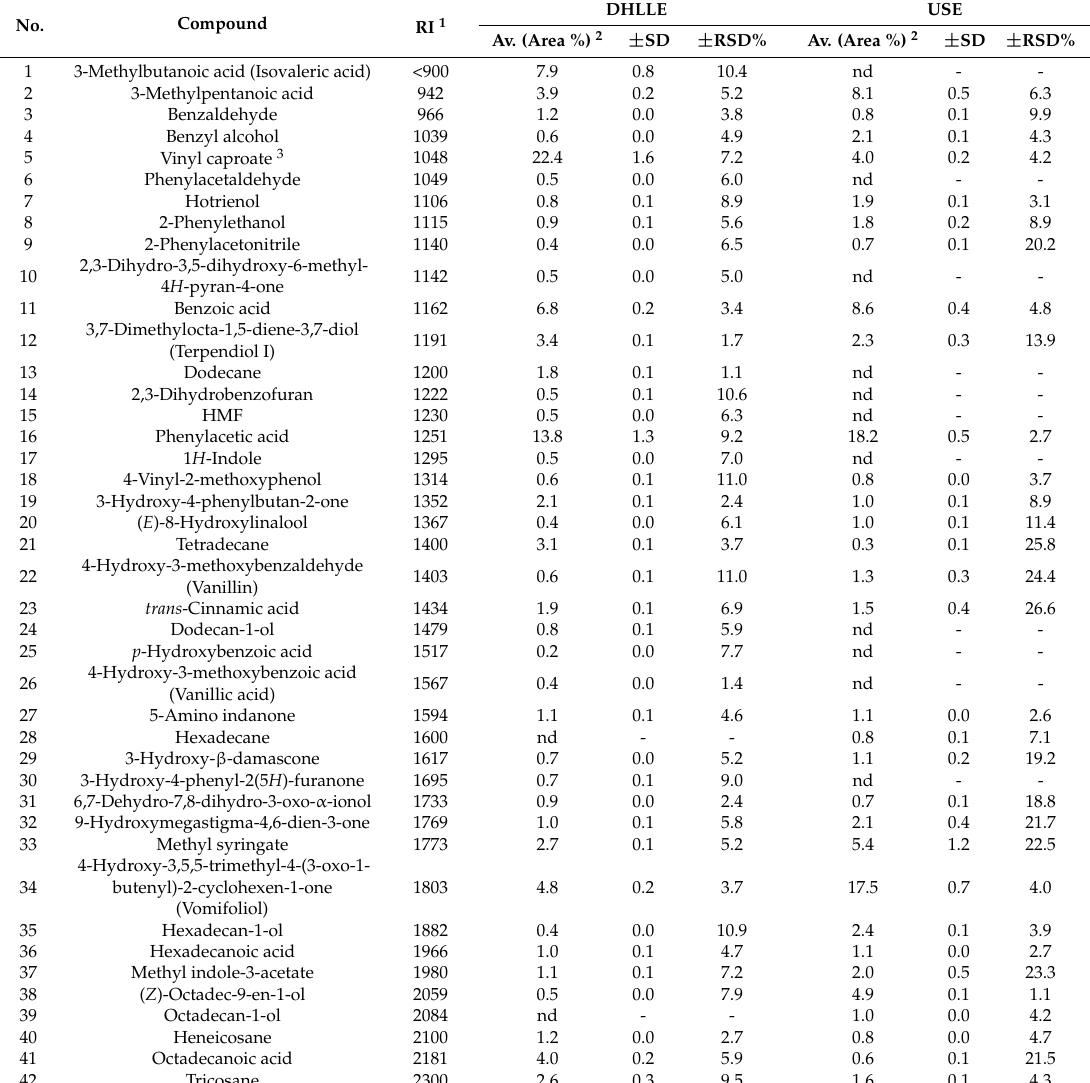
Table 2. The comparison of volatile profiles obtained by the DHLLE and ultrasonic solvent extraction (USE) with